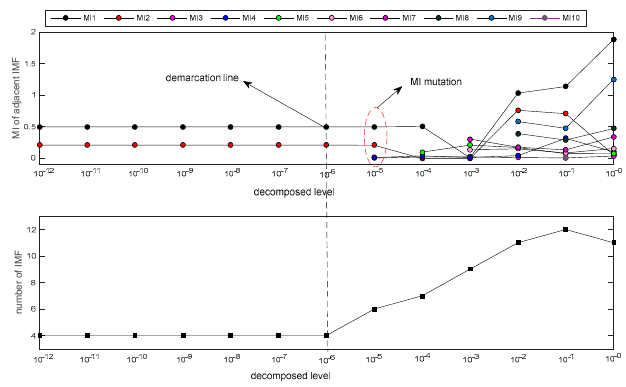
Figure 3. Decomposition results for the simulation signal (SSC) signal under different decomposition levels.